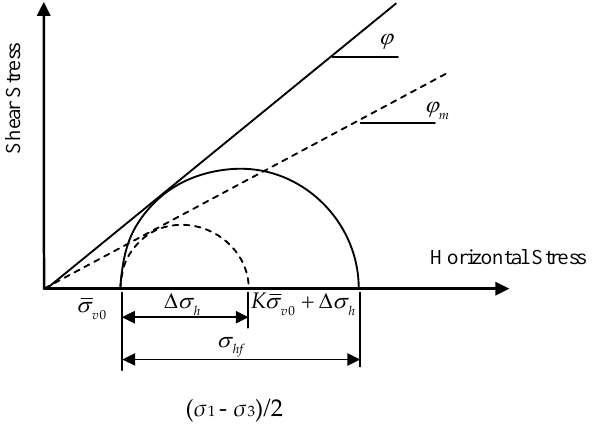
Figure 7. Mohr’s circle of the limit equilibrium state of a point in rock and soil mass.